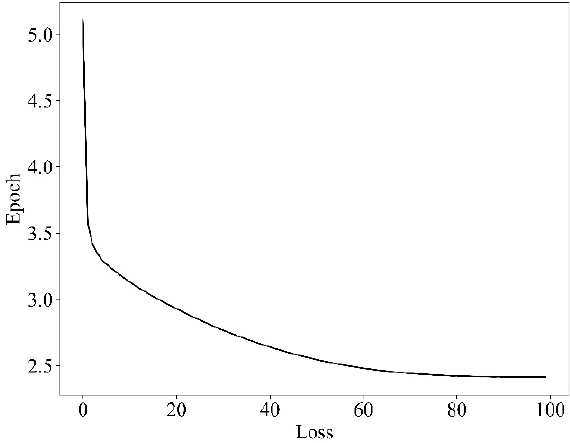
Figure 12. Training epoch–loss diagram.